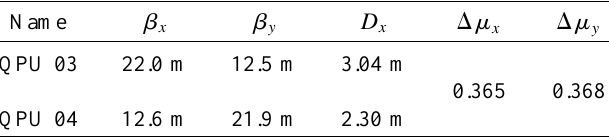
TABLE I. Beta function values and horizontal dispersion at the pickup locations. The horizontal and vertical phase advances be- tween the two locations are also given. The pickups are installed in consecutive straight sections of the PS machine.